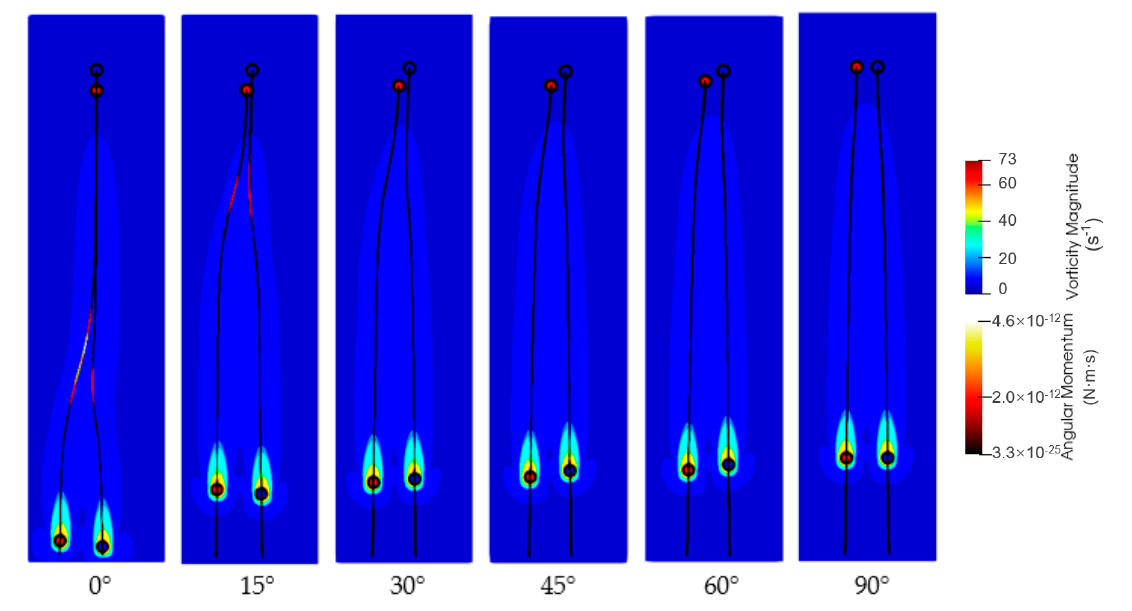
Figure 10. Total vorticity fields at 6 s from particles released with different angles. Re = 18.18 and particle center-to-center distance is 1.5 D p .